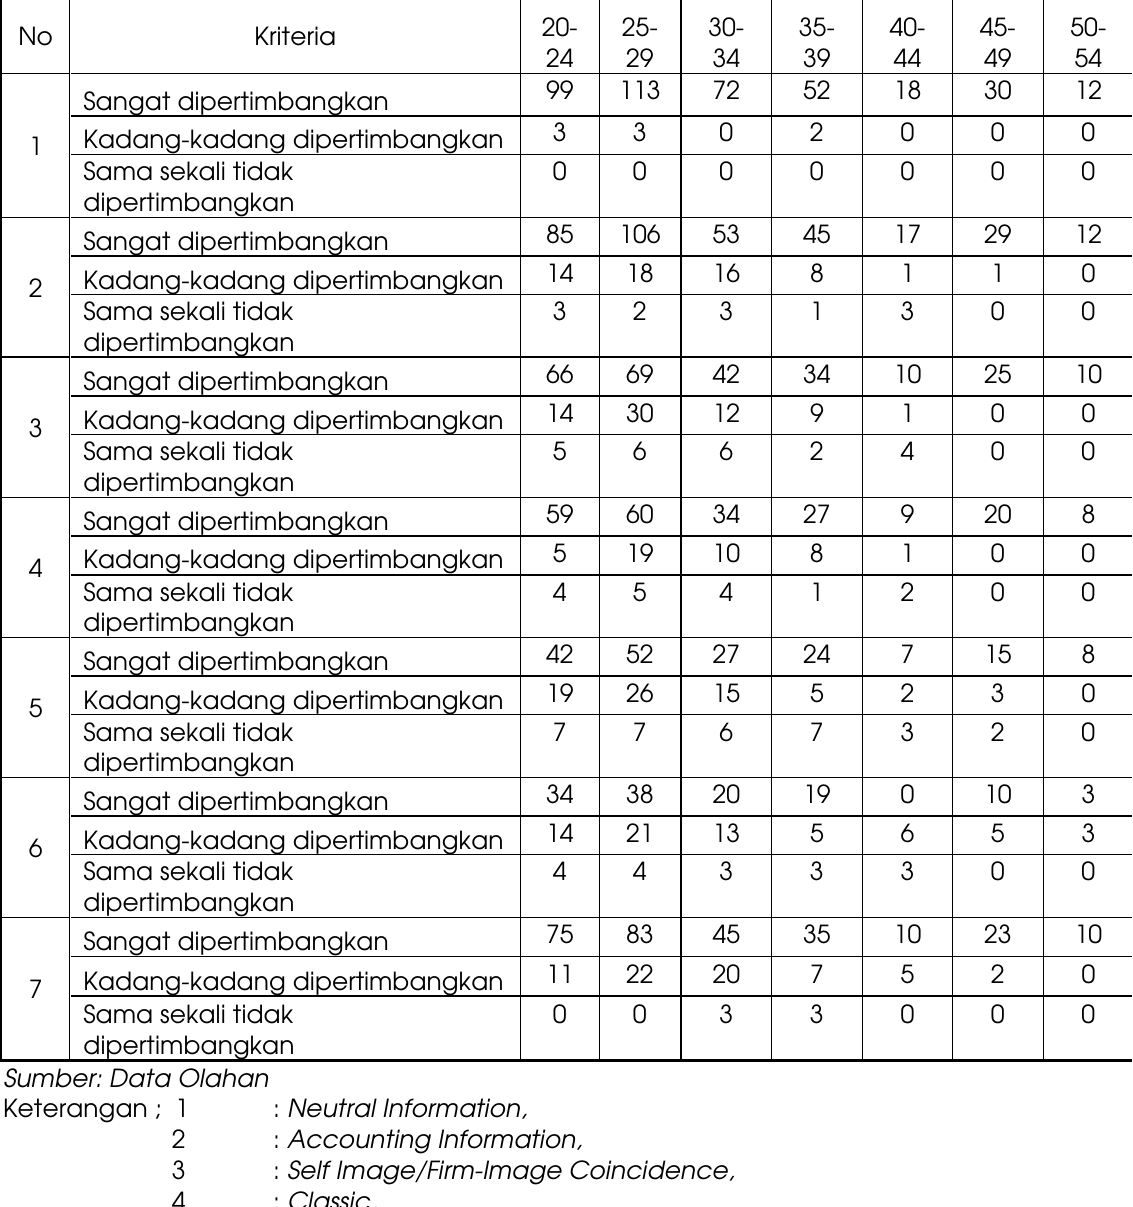
Tabel 7. Hasil Analisis Crosstab Usia dengan Kriteria dalam Pengambilan Keputusan Investasi